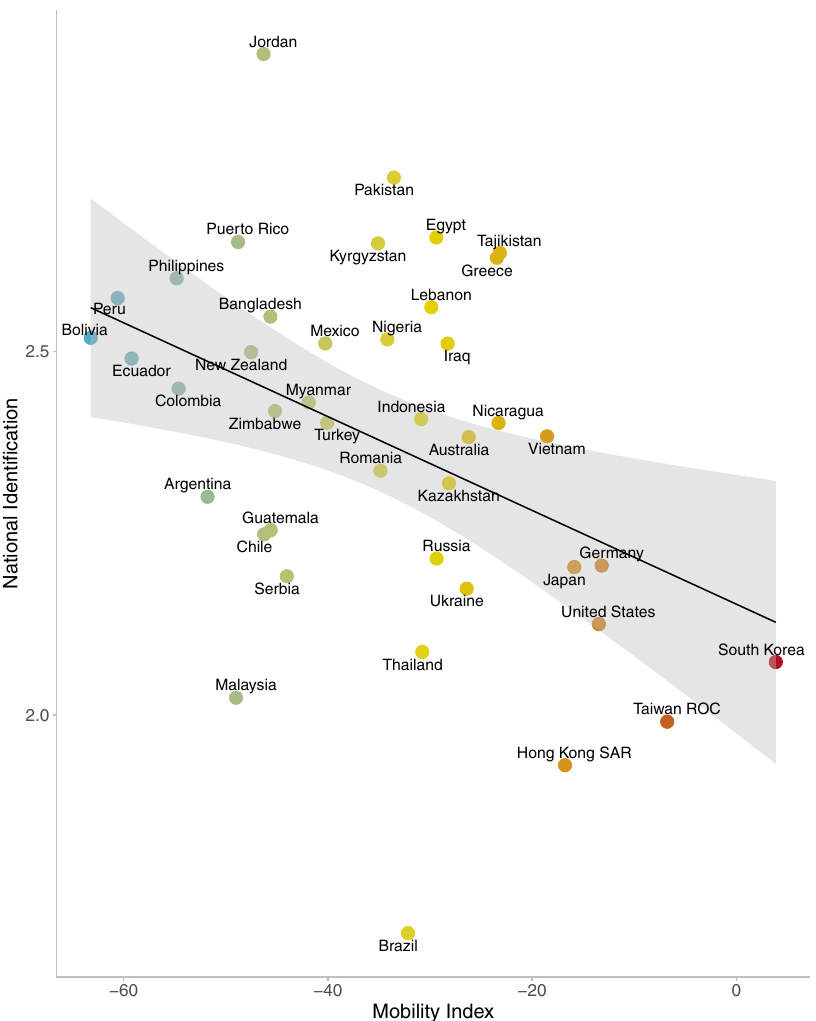
Fig. 4 Relation between national identi fi cation ( y -axis) and community mobility ( x -axis) in 42 countries and territories. Google mobility is depicted as a mean change in mobility during April and May 2020 (i.e., blueish colours indicate a greater reduction of mobility during this period while reddish colours indicate a smaller reduction of mobility). Grey shading is the 95% con fi dence